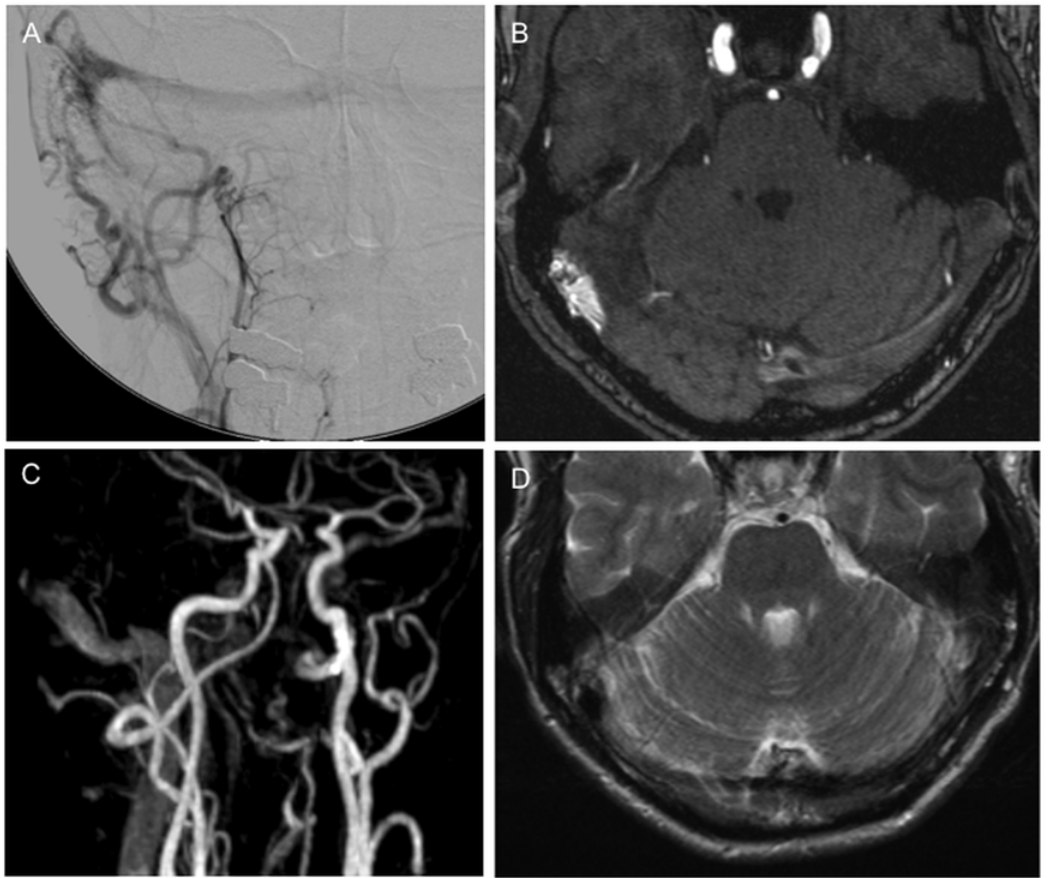
Fig 2. 53 year old patient with right-sided pulsatile tinnitus and severe headache since 4 months. DSA (A), TOF (B), ce-MRA (C) and T2 (D): DAVF IIa by Cognard/Merland classification at the sigmoid/transverse sinus.